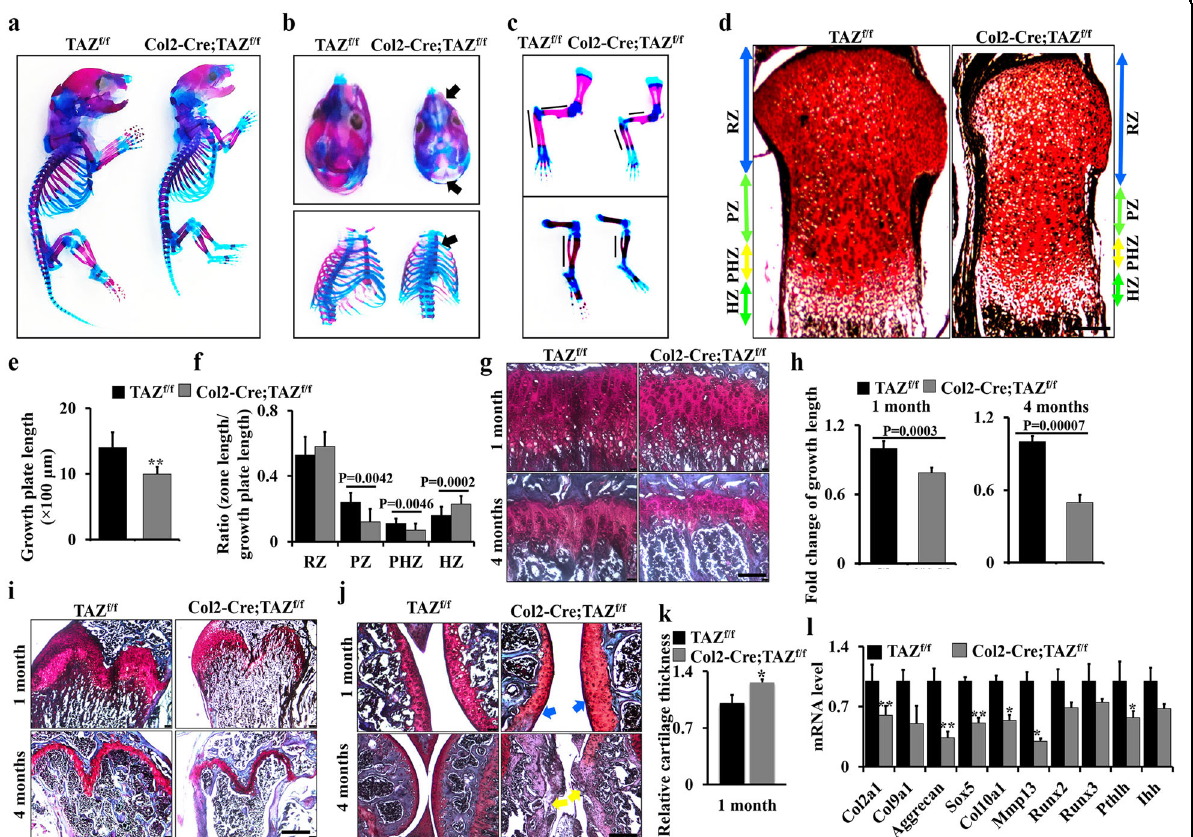
Fig. 2 Deletion of TAZ in chondrocytes inhibits growth plate and articular cartilage development. a – c Col2-Cre;TAZ f/f mice and controls at the newborn stage stained with Alizarin Red and Alcian blue. Calvarium, ribs, sternum, forelimb, and hindlimb are shown in b and c with higher magni fi cation. Black arrows point to the regions of chondrodysplasia ( n = 3 mice per group). d Representative Safranin O staining of the growth plate in the proximal tibiae of Col2-Cre;TAZ f/f mice and controls at the newborn stage. RZ resting zone, PZ proliferation zone, PHZ prehypertrophic zone, HZ hypertrophic zone. Scale bars, 100 μ m. e , f Quantitative analysis of growth plate length ( e ) and each zone ’ s lengths of growth plate ( f ) in Col2-Cre; TAZ f/f mice and controls at the newborn ( n = 3 mice per group). Data were reported as a ratio of the zone length to the total growth plate length ( f ). g , h Growth plate sections of the tibiae of Col2-Cre;TAZ f/f mice and controls ( n = 3 mice per group) from 1- and 4-month-old mice by Safranin O staining ( g ). Scale bars, 25 μ m. The corresponding quantitative analysis was performed ( h ). i Growth plate sections of the femurs of Col2-Cre;TAZ f/f mice and controls ( n = 3 mice per group) from 1- and 4-month-old mice by Safranin O staining. Scale bars, 100 μ m. j Histological sections of articular cartilage from 1- and 4-month-old male mice by Safranin O staining. Scale bars, 50 μ m (upper panel) and 100 μ m (lower panel). Blue arrows point to articular cartilage. Yellow arrows point to the regions of impaired articular cartilage integrity. n = 5 mice per group. k The cartilage thickness from Col2-Cre;TAZ f/f mice and controls were quanti fi ed at 1 month. n = 5 mice per group. l qRT-PCR analysis of chondrocyte differentiation markers using the cartilage samples from Col2-Cre;TAZ f/f mice and controls at E15.5. The experiment was independently repeated for three times. Error bars were the means ± SEM of triplicates from a representative experiment. * P < 0.05, ** P <